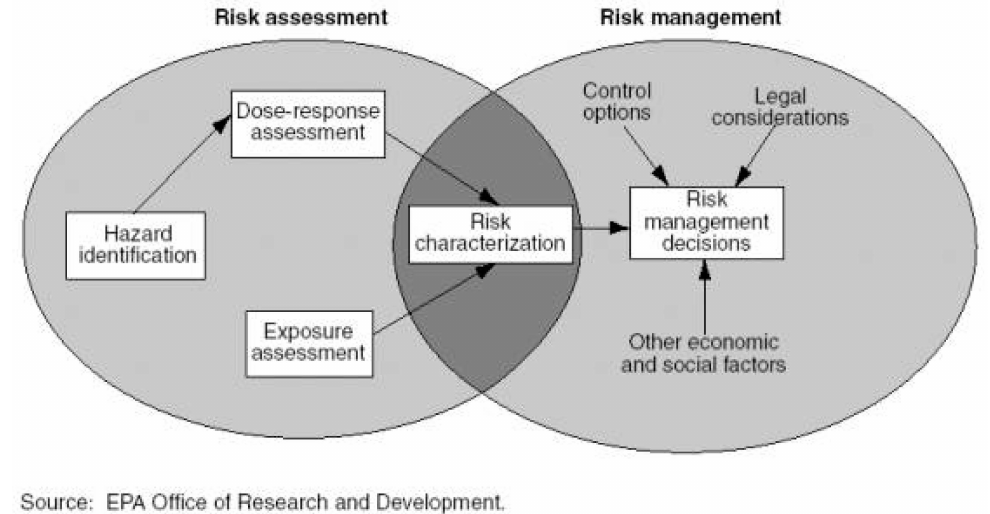
Figure 1. Diagram of the structural framework of the National Research Council (NRC) risk assessment/risk management paradigm